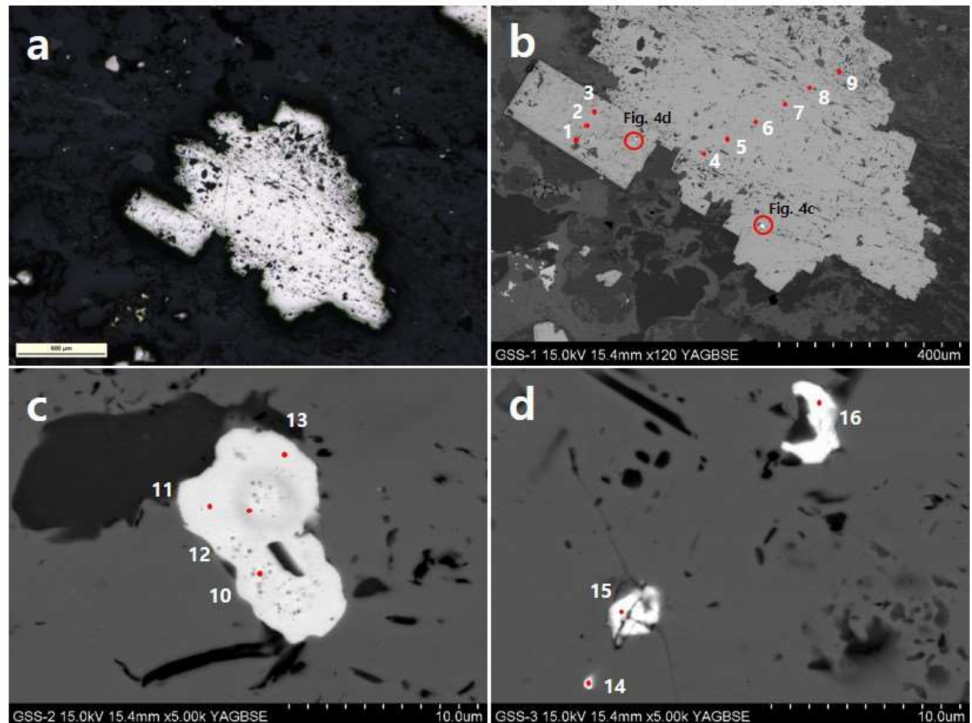
Figure 4. Reflected light photomicrograph ( a ) and SEM-backscattered electron (BSE) image ( b – d ) of a pyrite grain of the ore